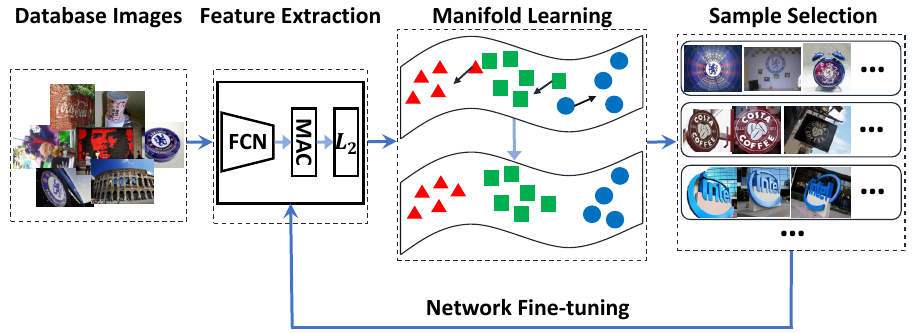
Figure 1. The pipeline of the proposed method. The pipeline consists of two stages: the self-supervised training example selection stage and the network fine-tuning stage. In the training example selection part, database images are firstly fed into the CNN model to extract MAC feature